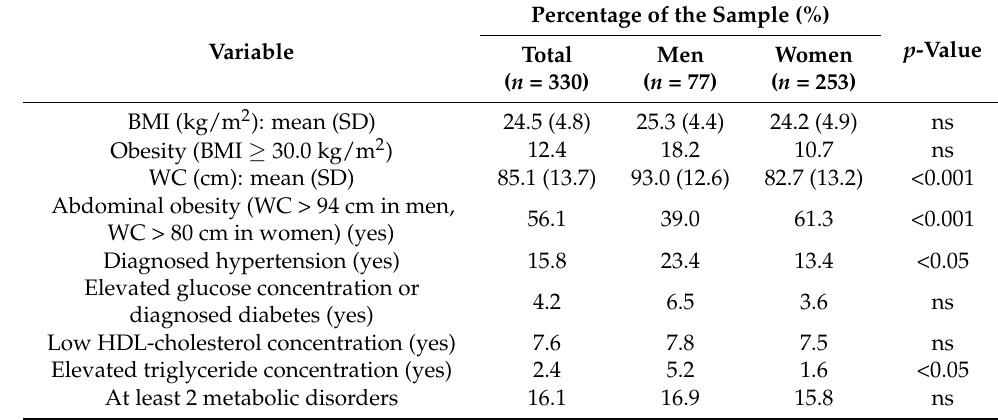
Table 2. Nutritional status and prevalence of metabolic